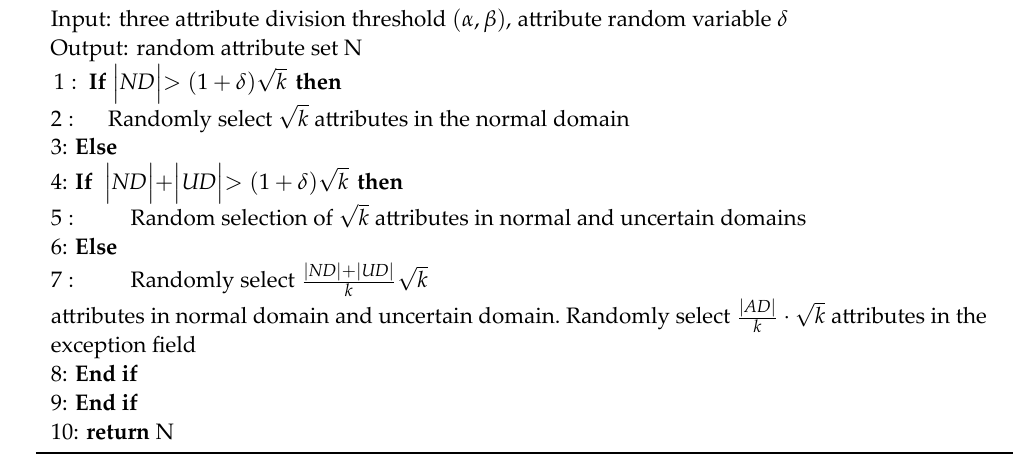
Algorithm 1: Random selection of three